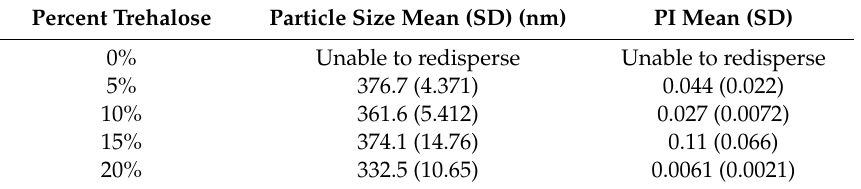
Table 8. E ff ect of trehalose concentration on particle size and distribution of SLNs after lyophilization. Particle Size Mean (SD)